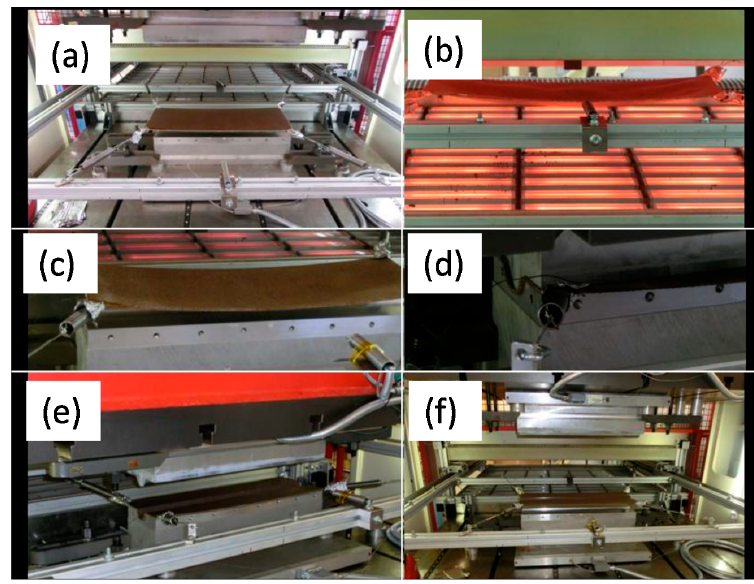
Figure 1. Forming process of the organic sheets. ( a ) deposit; ( b ) heating; ( c ) positioning; ( d ) forming; ( e ) cooling and ( f ) removing.